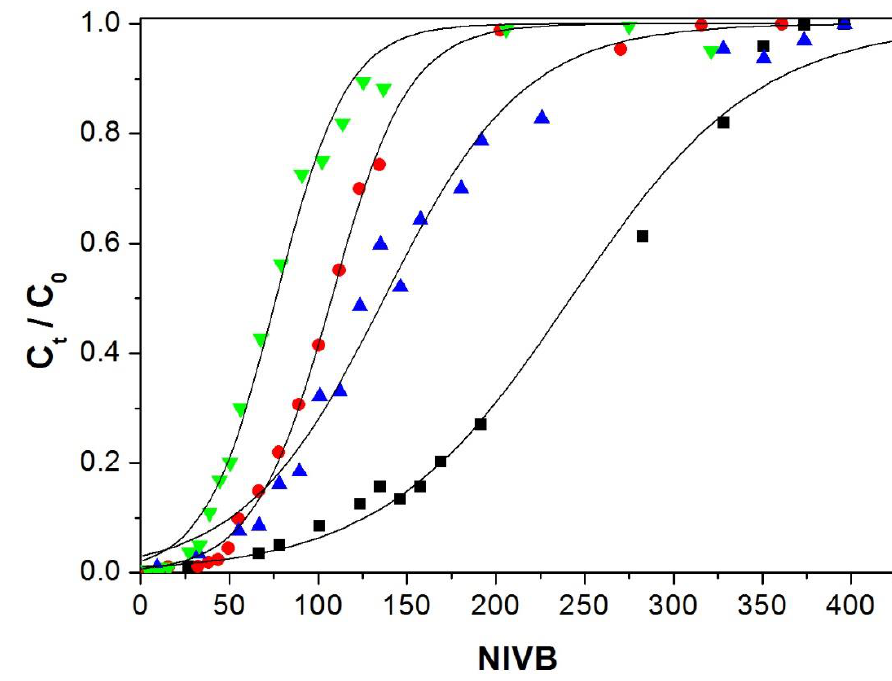
Figure 8. Breakthrough curves for Cu(II) adsorption, flow rate 100 mL/h, 13 cm height column. Experimental Alg-Ch: ■ 50 mg/L, ● 100 mg/L. Experimental Alg-ChS hydrogel: ▲ 50 mg/L, ▼ 100 mg/L. Thomas model predictions (—).